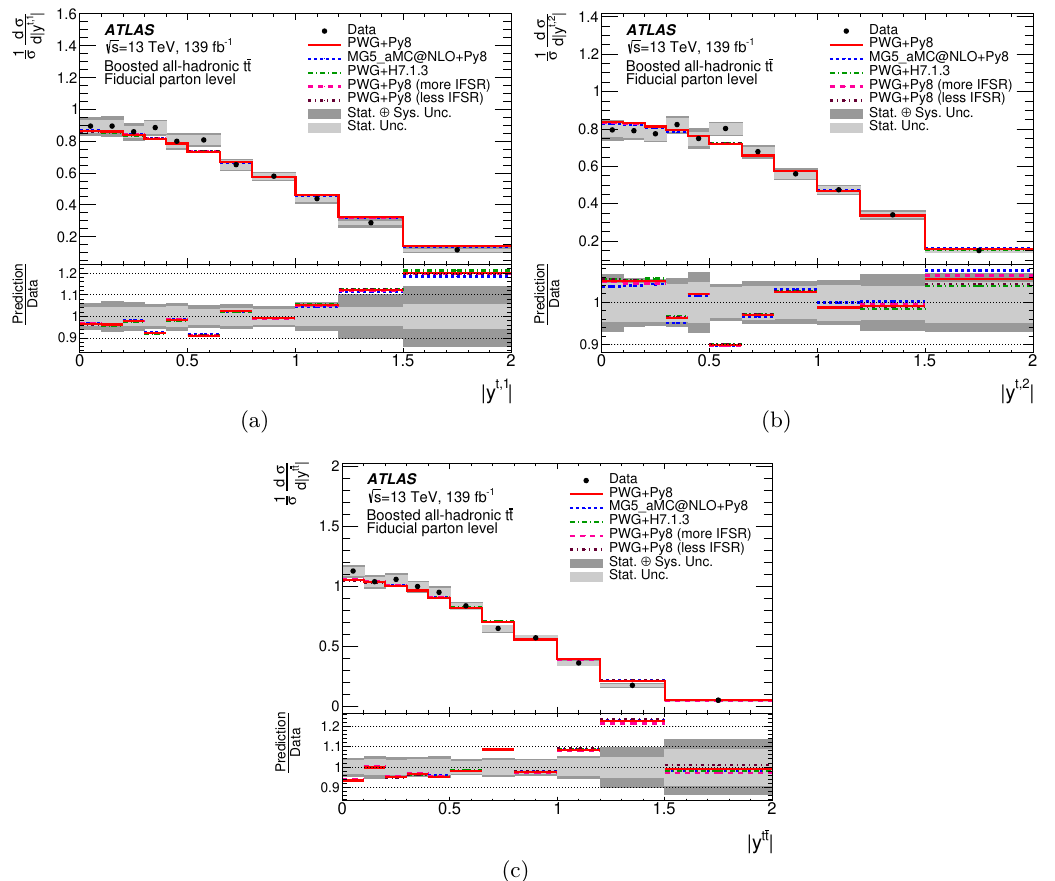
Figure 23 . Normalized parton-level fiducial phase-space differential cross-sections as a function of the absolute value of the rapidity of (a) the leading top quark, (b) the second-leading top quark, (cid:12) (cid:12) (cid:12) (cid:12) and (c) the t ¯ t system, y t ¯ t . The dark and light grey bands indicate the total uncertainty and the (cid:12) (cid:12) statistical uncertainty, respectively, of the data in each bin. Data points are placed at the centre of each bin. The Powheg+Pythia 8 MC sample is used as the nominal prediction to correct the data to parton